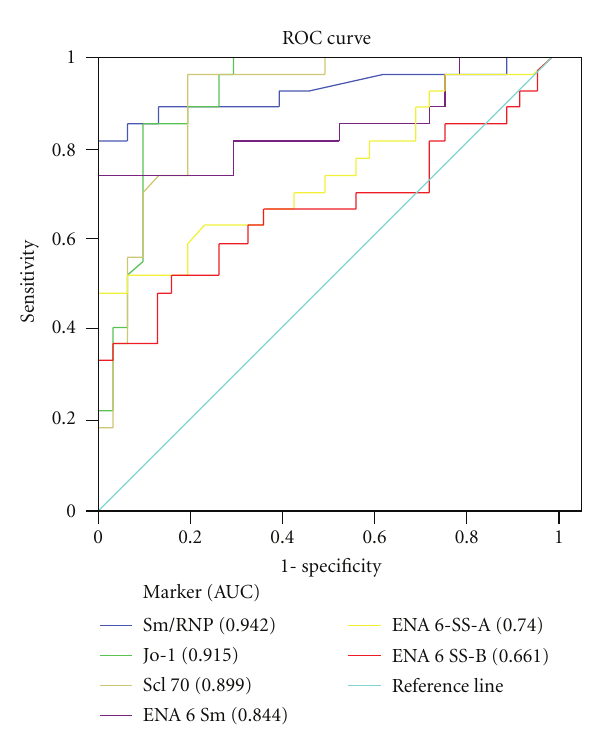
Figure 11: Receiver operating characteristic (ROC) curve of ENA6 profile markers for di ff erentiation between SLE for patients and healthy